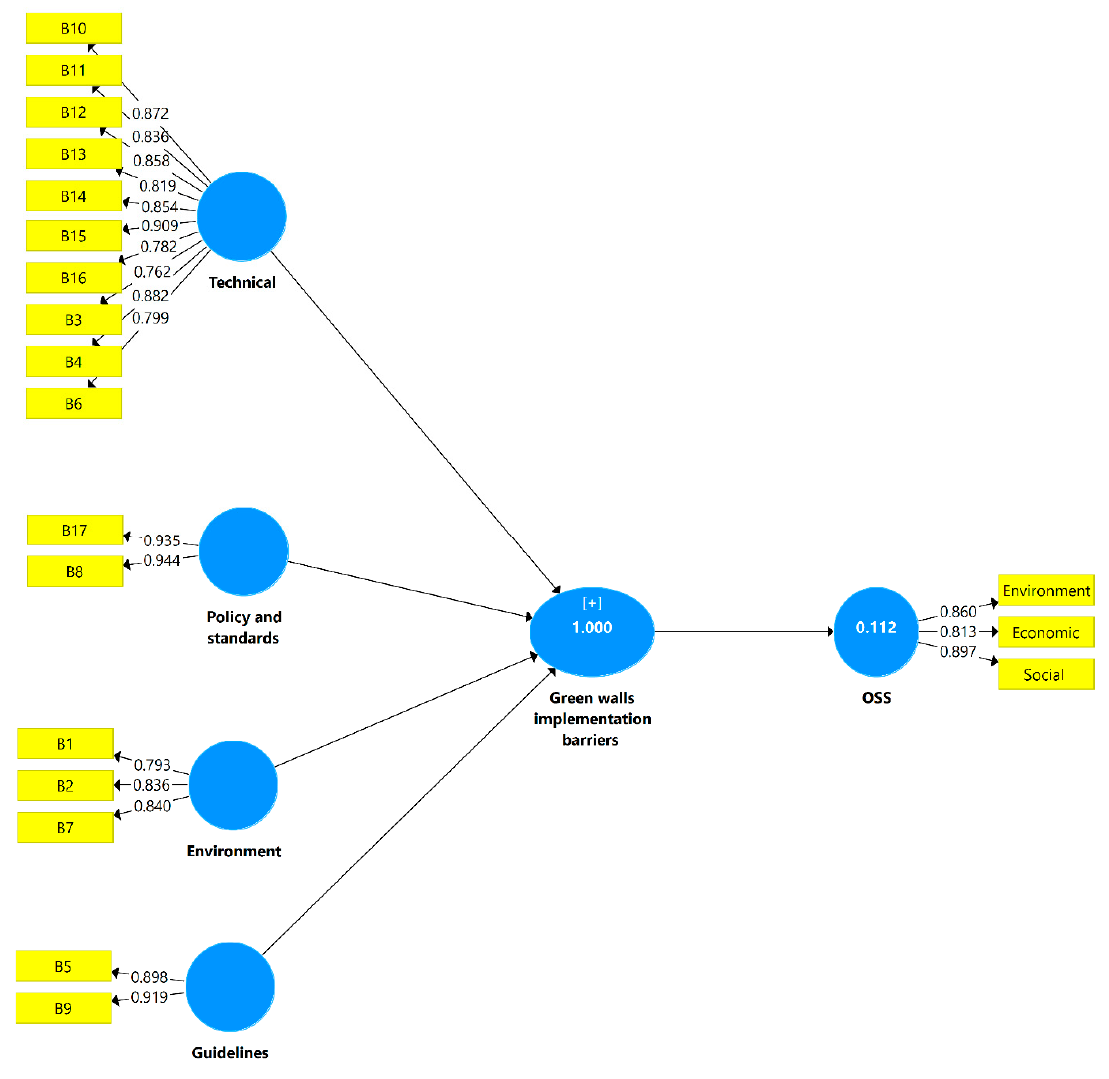
Figure 4. The PLS initial model. Table 5. Discriminant validity